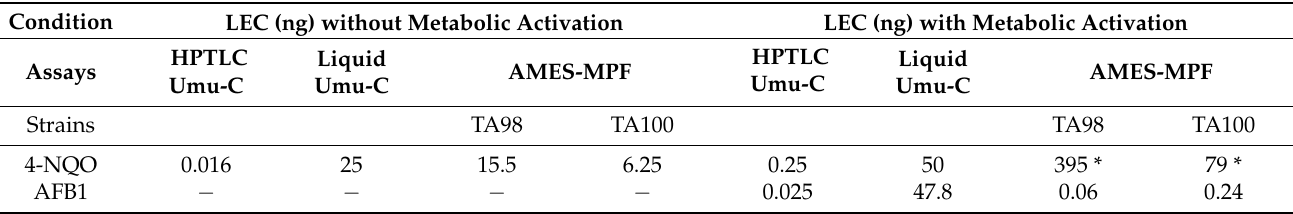
Table 3. Comparison of the LECs of the p-Umu-C, SOS Umu-C and AMES-MPF (TA98 and TA100)